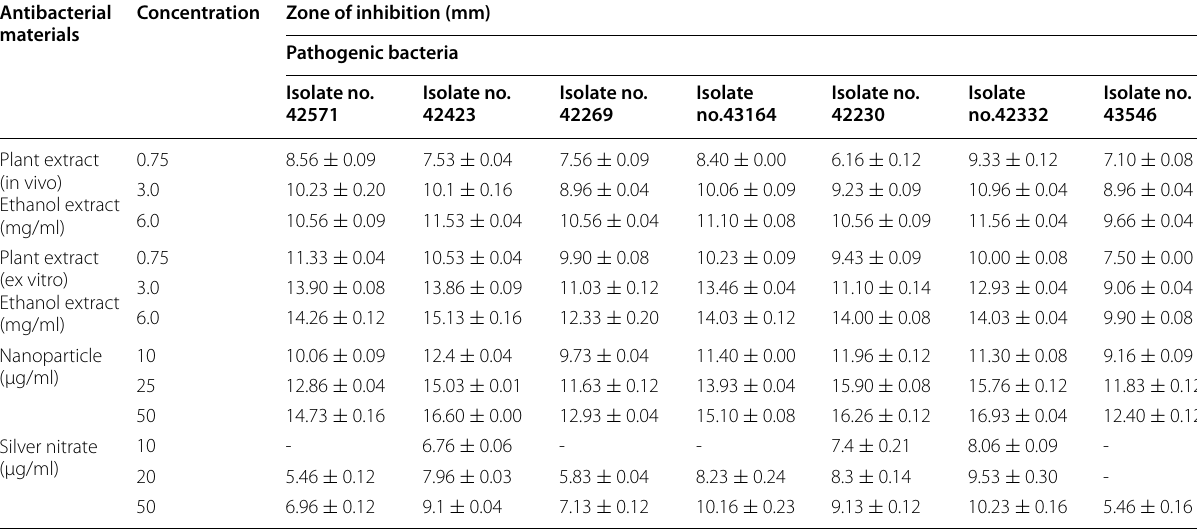
Table 2 Comparative antimicrobial activity of in vivo and ex vitro Kaempferia angustifolia (ethanol extract) and silver nanoparticle against UTI clinical